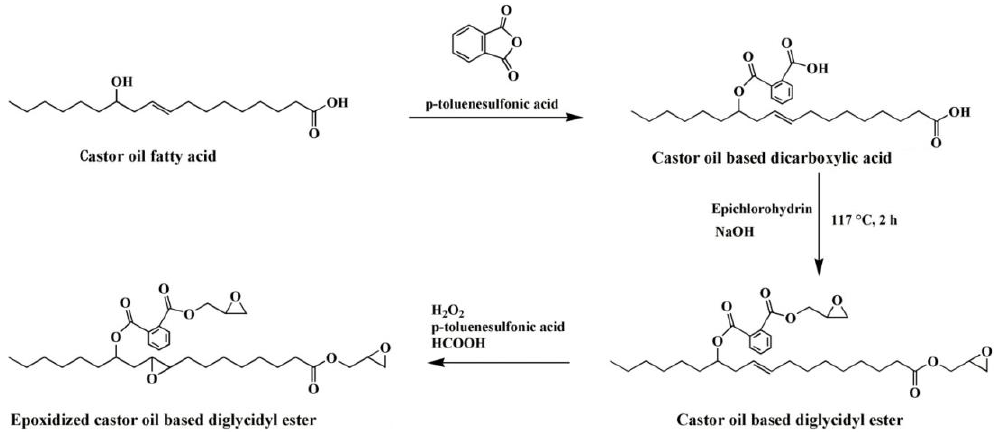
Figure 3. Synthesis of epoxidized castor oil based diglycidyl ester.